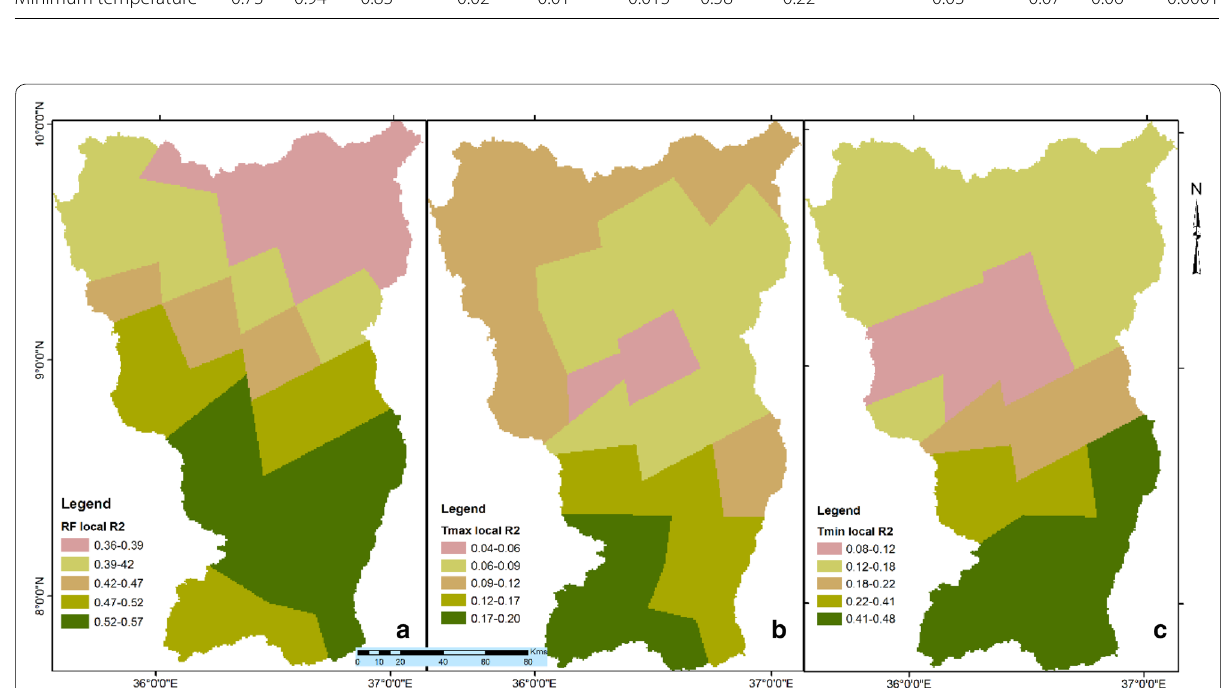
Fig. 6 Spatial variation of local r 2 for rainfall ( a ), maximum temperature ( b ) and minimum temperature ( c